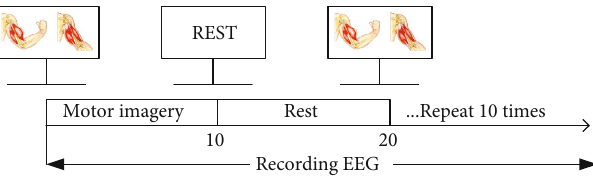
Figure 2: Location map of EEG collection.